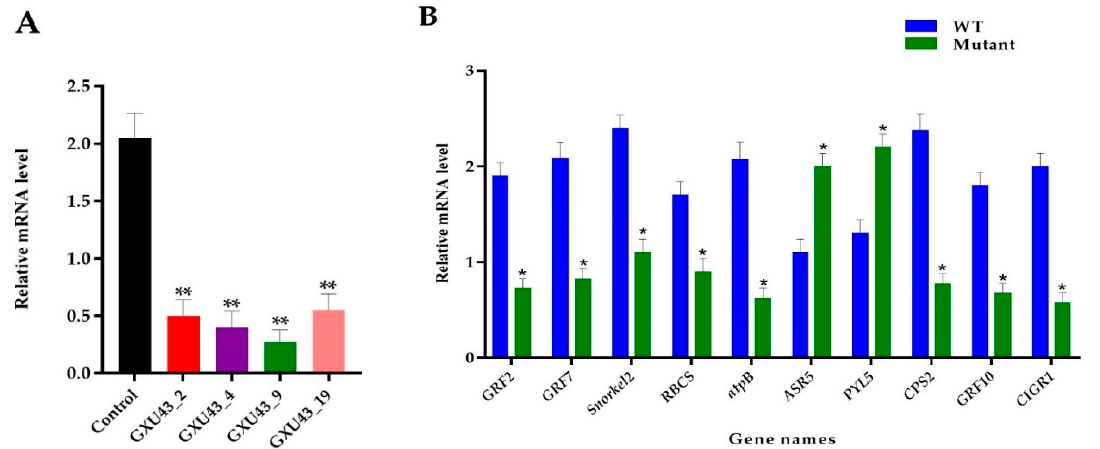
Figure 8. Real-time quantitative PCR assessment and validation of proteomics data. ( A ) Expression analysis of OsGA20ox2 , in WT and T 1 mutant lines, ( B ) RT qPCR validation of the ten DEPs responsive genes. The SD is shown with error bars, “*” represents the significant differences at p ≤ 0.05 and “**” represents the significant differences at p ≤ 0.01 respectively; n = 3.